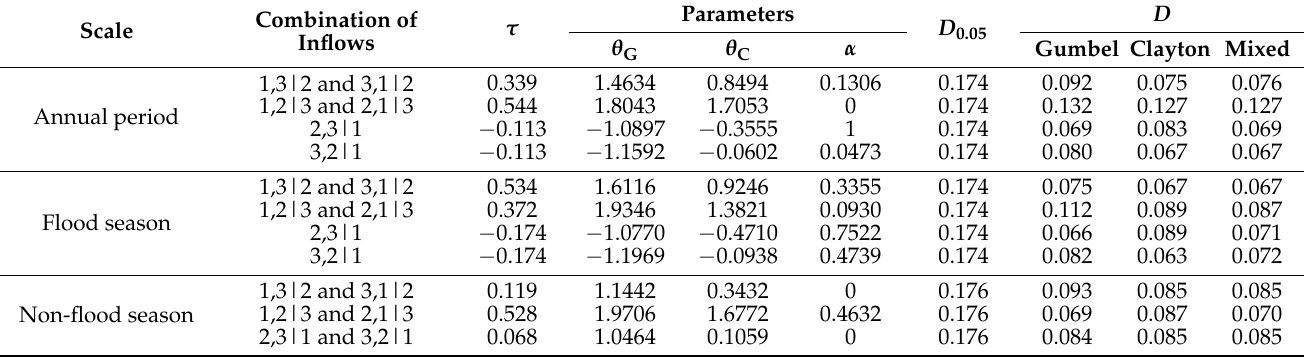
Table 7. The results of the parameter estimation and K-S tests of the conditional binary copula functions between each two